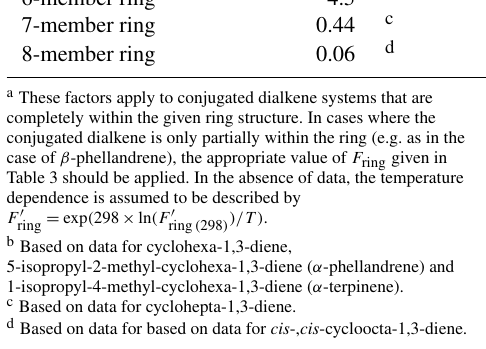
, for the reac- ring ( 298 )